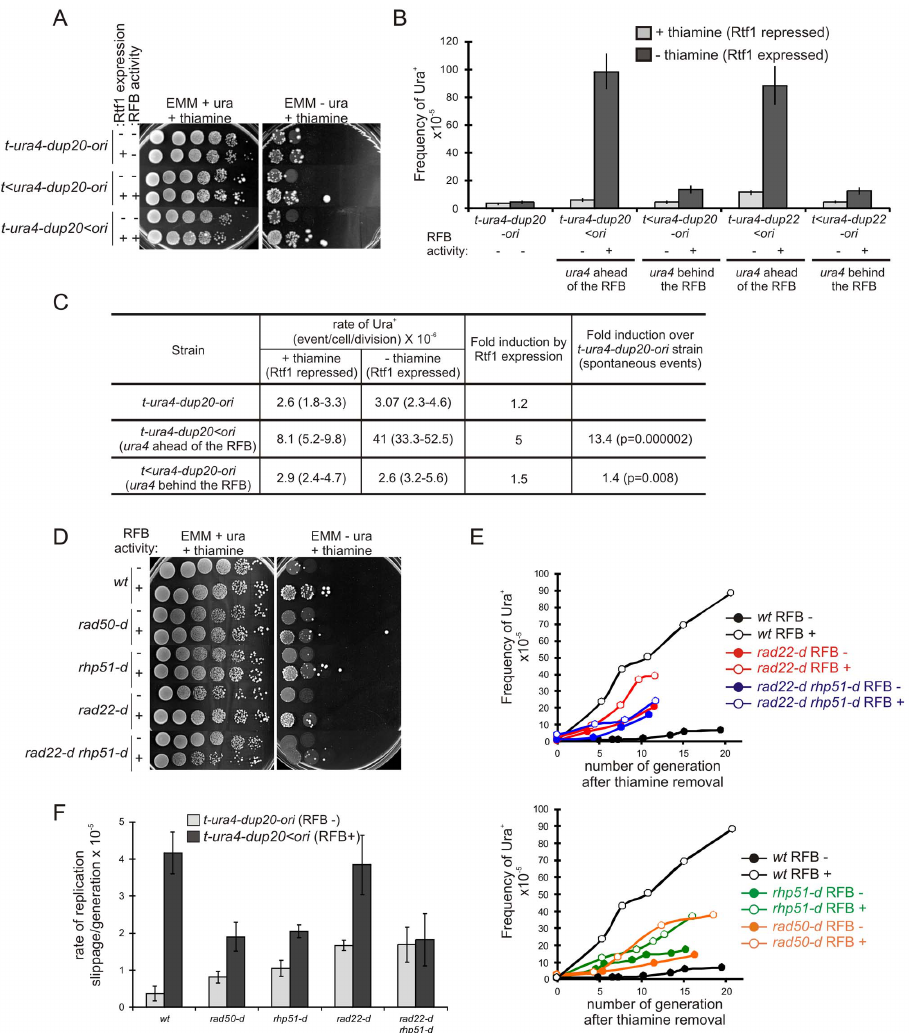
Figure 4. Fork recovery by homologous recombination results in replication slippage. A. Serial tenfold-dilutions from indicated strains ( t- ura4-dup20-ori associated or not with the RTS1 -RFB) were spotted onto the indicated media after cell growth with (Rtf1 -, repressed) or without (Rtf1 + , expressed) thiamine. RTS1 -RFB activity is given for each construct and condition. B. Frequency of Ura + revertants in indicated strains after cell growth with (Rtf1 repressed) or without (Rtf1 expressed) thiamine. The RTS1 -RFB activity is given for each construct and condition. Values correspond to the mean of at least three independent experiments and error bars correspond to the standard error of the mean (SEM). C. Rate of replication slippage in the indicated strains and conditions. The rate of Ura + revertants was calculated using the method of the median from at least 11 independent cultures. Values in brackets indicate the 95% confidence interval. Statistical significance was detected using the nonparametric Mann- Whitney U test. D. Serial tenfold-dilutions from the strains indicated spotted onto the media indicated after cell growth without thiamine. RTS1 -RFB activity ‘‘–’’ refers to the strain t-ura4-dup20-ori and ‘‘ + ’’ refers to the strain t-ura4-dup20 , ori . E. Kinetics of Ura + revertants frequency for the strains indicated as a function of the number of generations after thiamine removal. RTS1 -RFB activity ‘‘–’’ refers to the strain t-ura4-dup20-ori and ‘‘ + ’’ refers to the strain t-ura4-dup20 , ori . The values reported are the means of two experiments. F. The rate of replication slippage/generation for the strains indicated with ( t-ura4-dup20 , ori ) or without ( t-ura4-dup20-ori ) the active RTS1 -RFB. The rate was calculated from the slope of the curves presented in panel F. The values reported are means of three independent experiments and error bars correspond to SE.